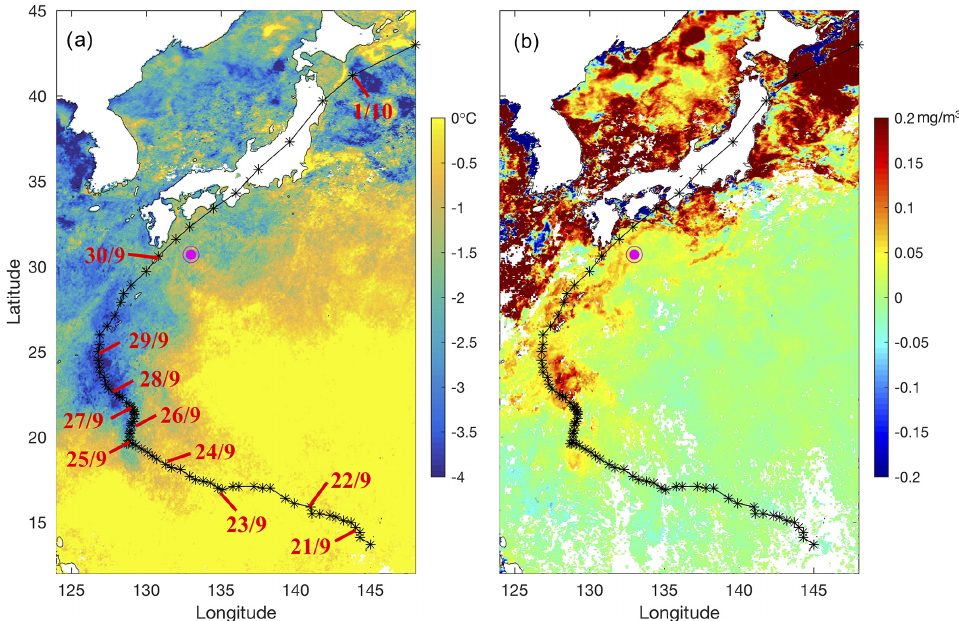
Figure 1. The differences in averaged sea surface temperature (a) and chlorophyll (b) measured during the period from 10 to 30 September vs. that measured from 1 to 20 October. The remote sensing observations were obtained as the MODIS L3 daily data. The trajectory of Typhoon Trami is shown as a black curve with its central location every 3h labeled as asterisks and the date labeled for the location at noon (UTC). The location of the Biogeochemical Argo (BGC-Argo) float on 30 September is shown as a magenta symbol.